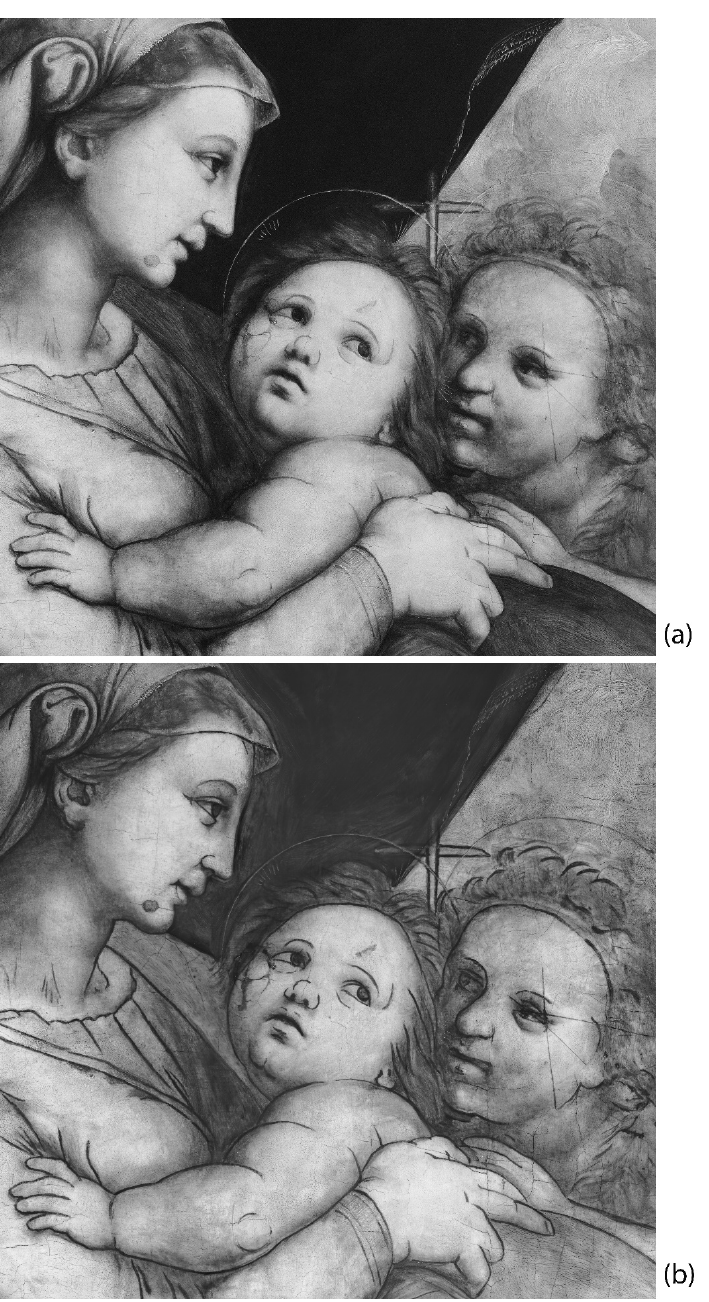
Figure 11. NIR ( a ) and HR-SWIR ( b ) reflectography image comparison showing the difference in revealing the underdrawing made with a brush and a carbon black ink.